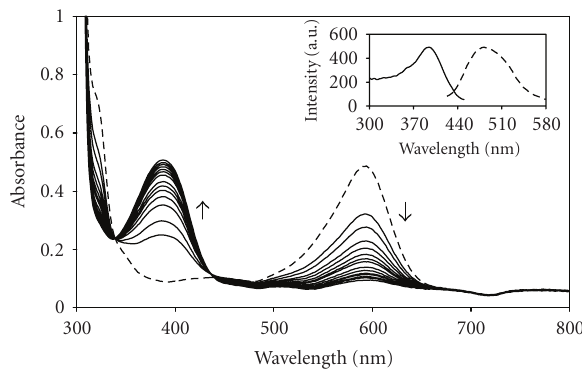
Figure 2: UV/Vis spectra recorded for an indigotetrasulfonate (ITS) deoxygenated aqueous solution 2 . 8 × 10 − 5 moldm − 3 , pH4): broken line. Upon reaction with a zinc amalgam pellet, the blue ITS solution is reduced to leuco -indigotetrasulfonate ( leuco -ITS), signalled by the decrease in absorbance at 590nm and the increase at 390 nm (spectra were recorded every 30 minutes). The insert diagram illustrates the excitation spectrum (solid line; λ em = 485 nm) and emission spectrum broken line; λ ex = 390 nm) of a 2 . 8 × 10 − 5 moldm − 3 leuco -ITS deoxygenated aqueous solution, at